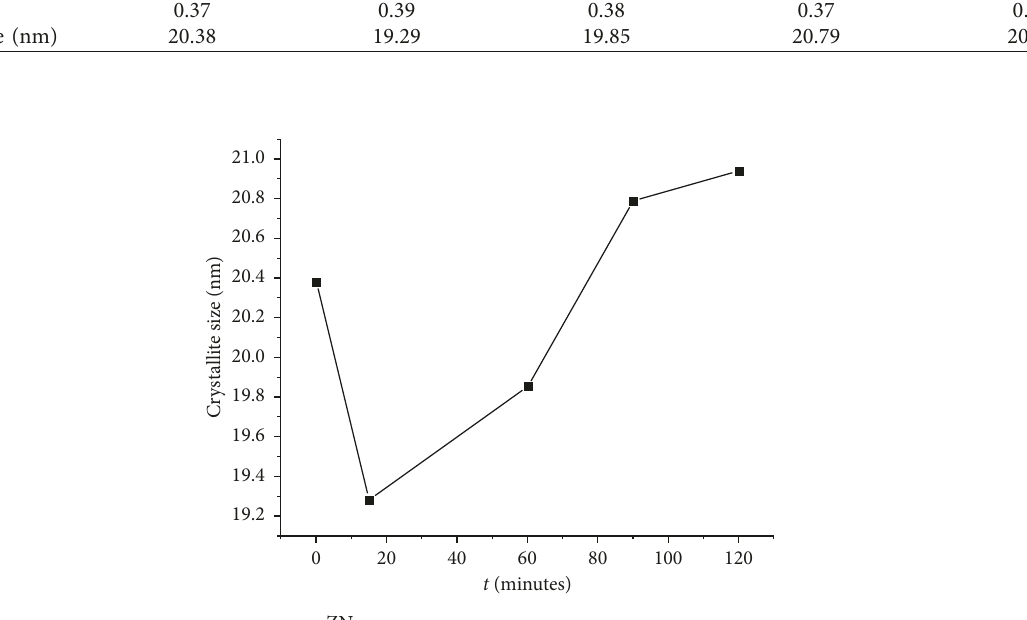
Figure 7: Linear plotting of crystallite size in a chart as a function of growth time t for ZnO NRs grown from the ZN source.